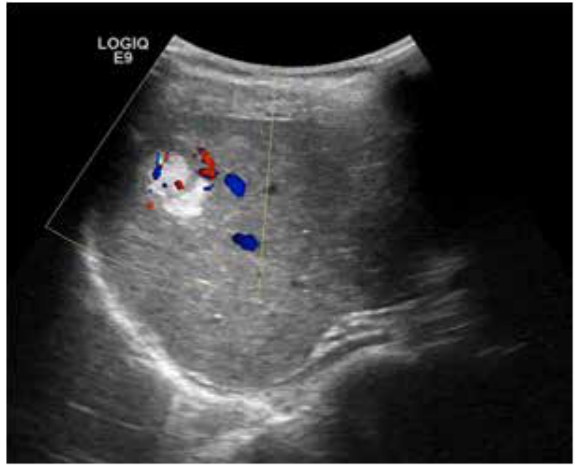
Figure 1 The gray-scale ultrasonography showed a heterogeneous hyperechoic lesion in segment 7 of the liver and vessels were found inside and around the